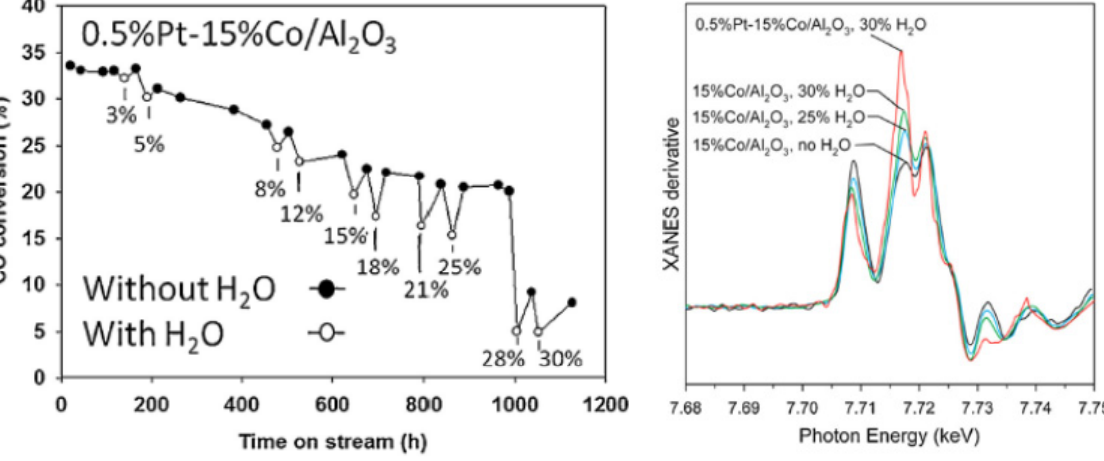
Figure 10. ( left ) Co-feeding of H :CO = 2:1, SV = 8 SL/g MPa, H 2 reversible effect) is observed at 28% H catalyst reveals formation of cobalt aluminate through reaction of the CoO formed with the support. Reprinted with permission from [40,49,50]. Copyright (2002, 2003, 2004) Elsevier.